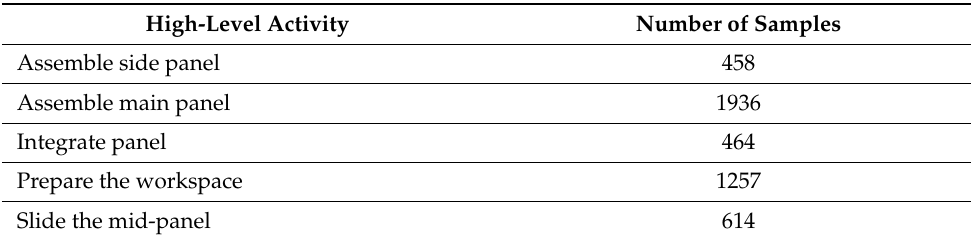
Figure 15. RULA score distribution. Table 12. Number of samples.